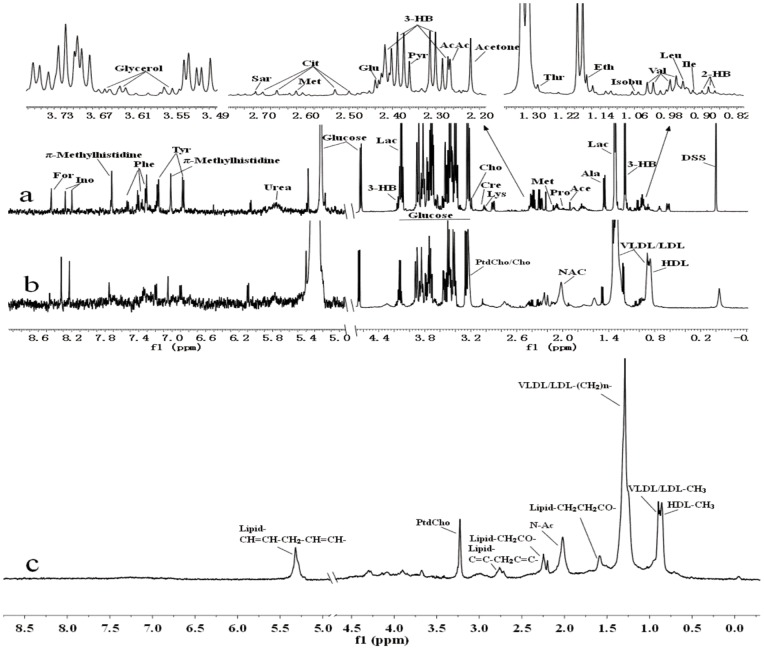
500 MHz 1H NMR spectra of plasma samples.(a) 1H-NMR spectra of plasma samples after filtration. (b) 1H-NMR CPMG spectra of plasma samples. (c) 1H-NMR BPP-LED spectra of plasma samples. Abbreviations: 2-HB, 2-hydroxybutyrate; Isobu, isobutyrate; Ile, isoleucine; Leu, leucine; Val, valine; Eth, ethanol; 3-HB, 3-hydroxybutyrate; Lac, lactate; Ala, alanine; Ace, acetate; AcAc, acetoacetate; Pro, proline; Pyr, pyruvate; Glu, glutamine; Cir, citrate; Met, methionine; Sar, sarcosine; Lys, lysine; Cre, creatine; Cho, choline; Tyr, tyrosine; Phe, phenylalanine; Ino, inosine; For, formate; VLDL, very low-density lipoprotein; LDL, low-density lipoprotein; HDL, high-density lipoprotein; PtdCho, phosphatidylcholine; and N-Ac, N-acetyl glycoproteins.